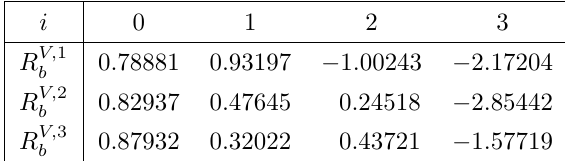
Table 2 . Perturbative coe(cid:14)cients r V;n for the ratios of the bottom vector-current correlator. We i show only terms which do not involve logarithms.